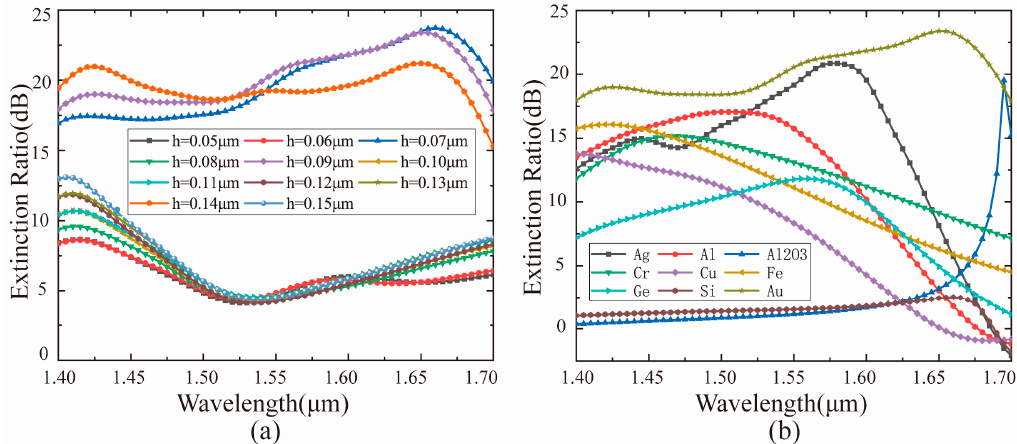
Figure 7. The influence of catenary antenna thickness and material on extinction ratio and operating bandwidth of the coupler. ( a ) The thickness values of the catenary antenna are different. ( b ) Catenary antennas are composed of different materials.